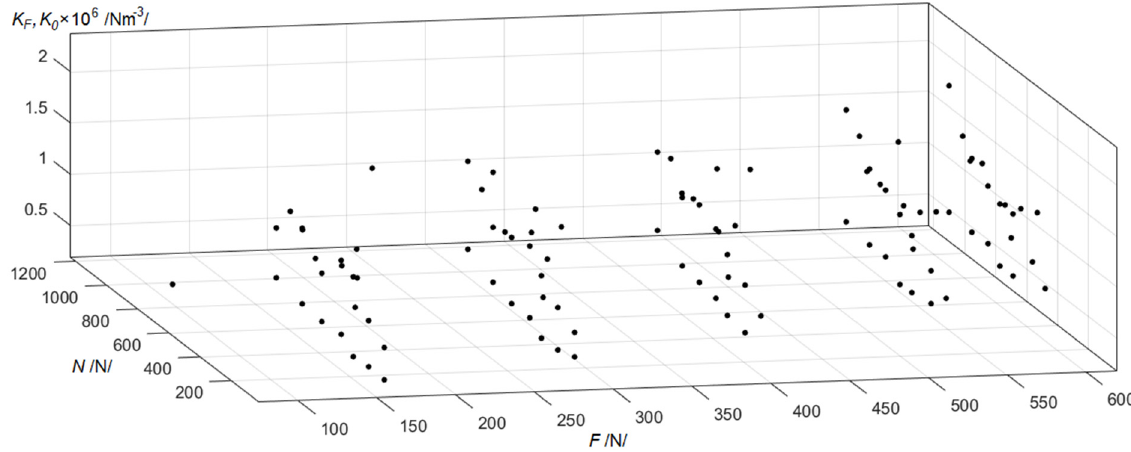
Figure 8. Relationship K F , K 0 = function ( F , N ) /Nm − 3 / for wheat layer thickness h = 72 mm.